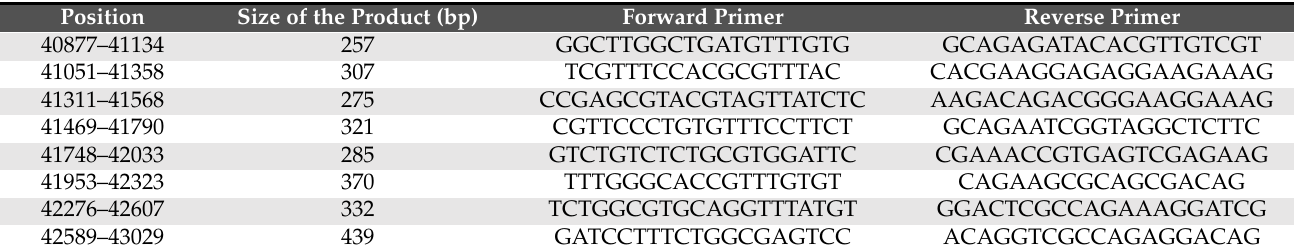
Table 5. Primers used for PCR